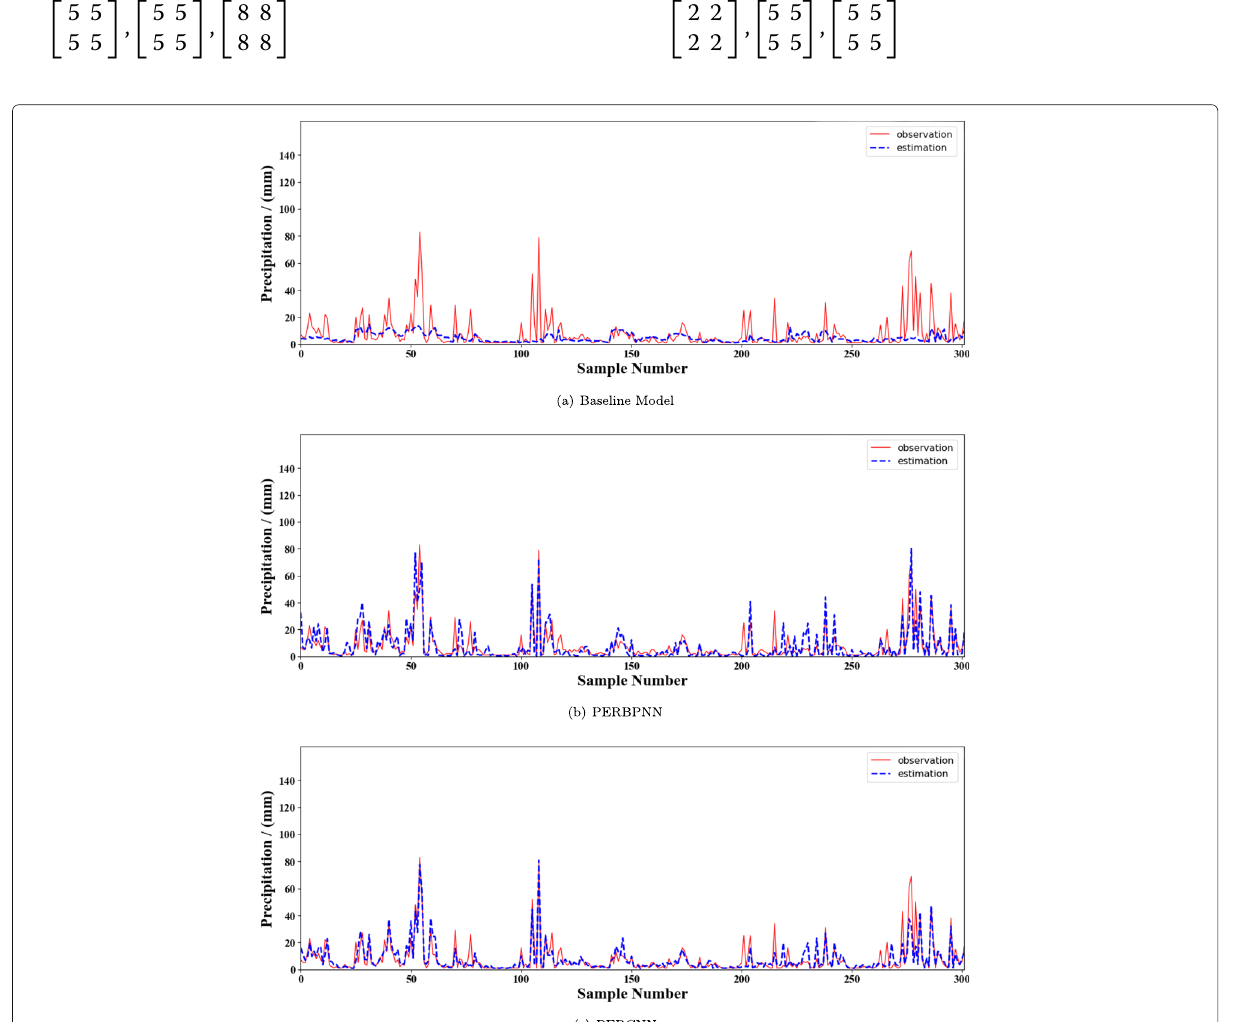
Fig. 8 Estimation results of test set with three